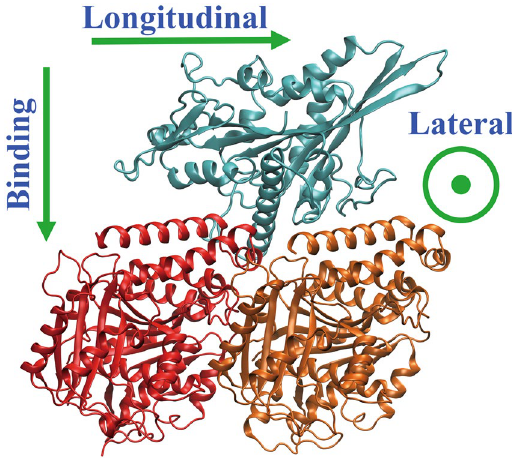
Figure 2. Definition of forces components. As an illustrative example, kinesin-3 family member KIF1A (light blue) is shown in the bound state on a tubulin dimer with α -tubulin (red) on the left side and β -tubulin (orange) on the right side. The “longitudinal” direction is along the microtubule, shown (green arrow) positive pointing toward the plus end. The “binding” direction is normal to the surface of the microtubule, shown (green arrow) positive toward the microtubule lumen. The “lateral” direction is around the microtubule, shown (green indicator) coming out of the page toward the reader.